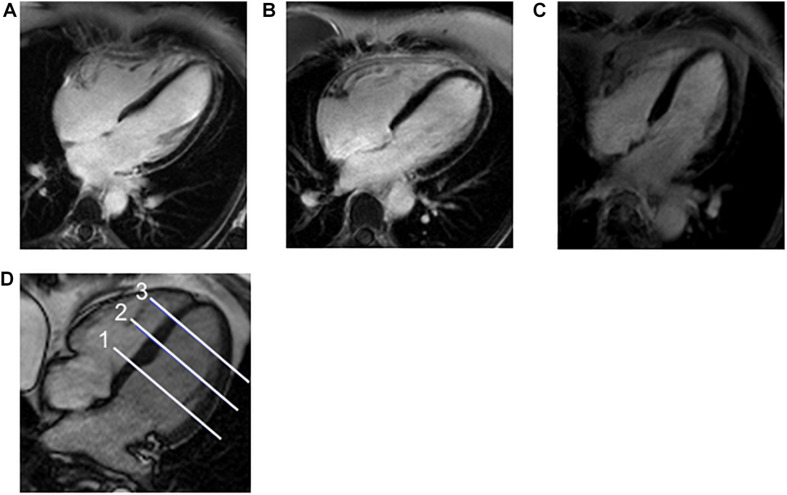
Example CMR Images and Location of Apex, Mid, and Base of Ventricles. (A–C) Representative four-chamber inversion recovery delayed enhancement images from three separate patients, without evidence of fibrosis. (D) A 4-channel steady-state free precession cine image demonstrating the usual position of the three short axis images that measure ECV for base (1), mid (2), and apex (3) of the left ventricle.